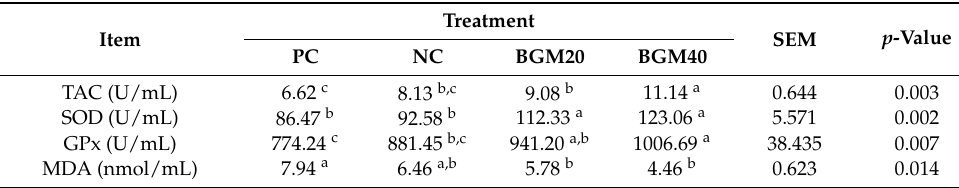
Table 6. Effect of dietary BGM with combined enzymes inclusion on oxidative stress of growing pigs 1 .